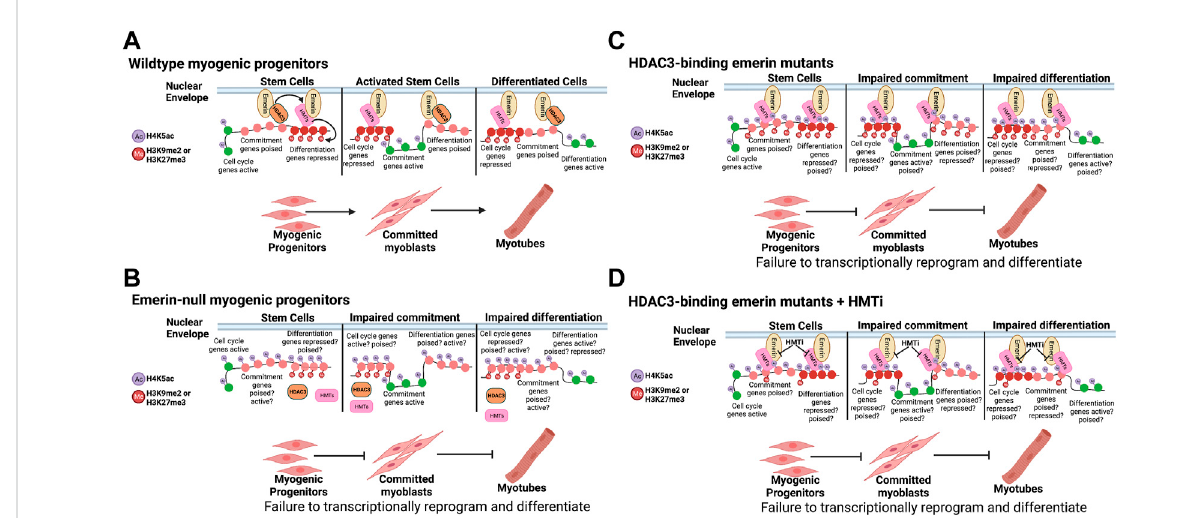
FIGURE 7 Model. (A) Wildtype myogenic progenitors dynamically reorganize their genome to coordinate the temporal expression of the differentiation program. (B) Cells lacking emerin fail to coordinate the temporal expression of key myogenic loci due to failure to dynamically reorganize the genome. (C) HDAC3-binding emerin mutants are predicted to exhibit dually acetylated and methylated chromatin states on key myogenic loci, leading to failure to coordinate their temporal expression. (D) Failure of HMT inhibition to rescue differentiation of HDAC3-binding emerin mutants is predicted to bedue to thehyperacetylation of H4K5on keymyogenic lociindependentoftheir methylationstatus. This isconsistent with the role of HDAC3 in fLAD organization during myogenic and cardiomyogenic differentiation (Demmerle et al., 2012, 2013; Poleshko et al., 2017). This fi gure was created using BioRender